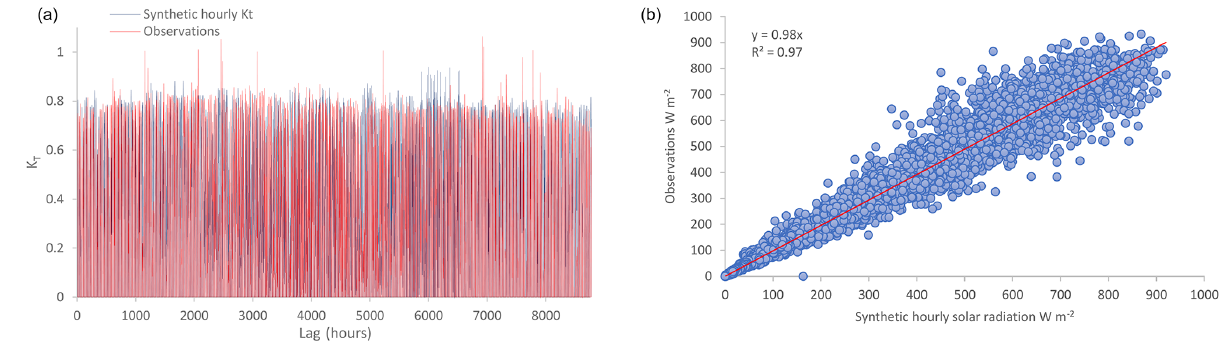
Figure 4. Results of the simulation model for the Denver Station: (a) 2-year synthetic timeseries of hourly K T ; (b) yearly average of hourly solar radiation observations vs. synthetic values of 15 years simulation.